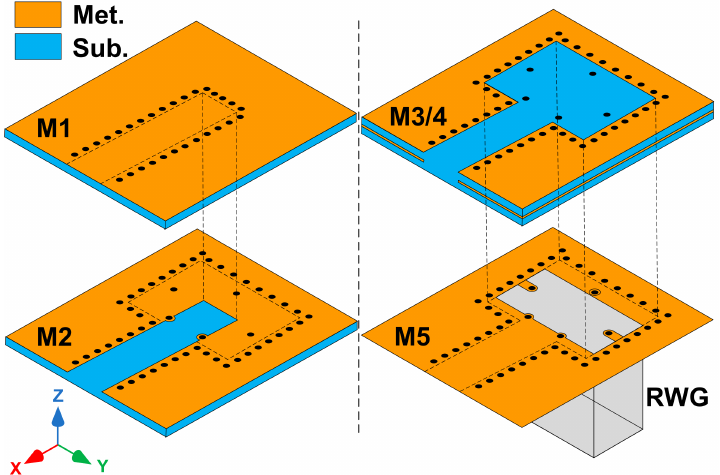
Figure 1. Exploded view of proposed transition with four layers of LTCC dielectric